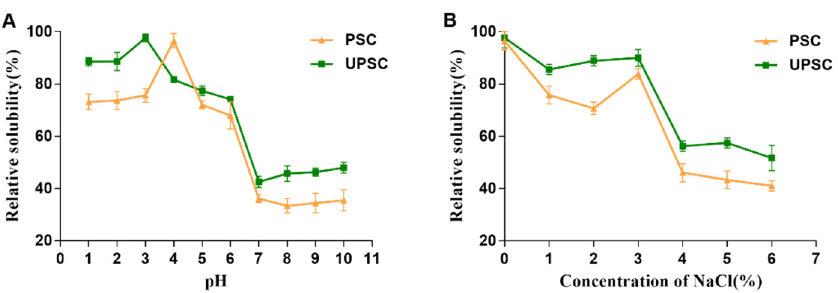
Figure 6. PSC and UPSC relative solubilities (%) at different ( A ) pH values and ( B ) NaCl concentra- tions (PSC, pepsin-solubilized collagen; UPSC, ultrasound-treated pepsin-solubilized collagen).